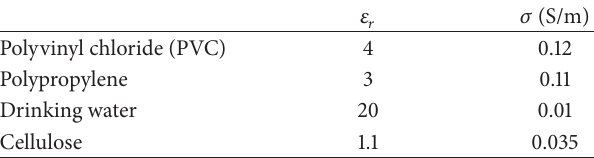
Figure 1: Details of the considered scenario for simulation. Table 1: Different material properties.